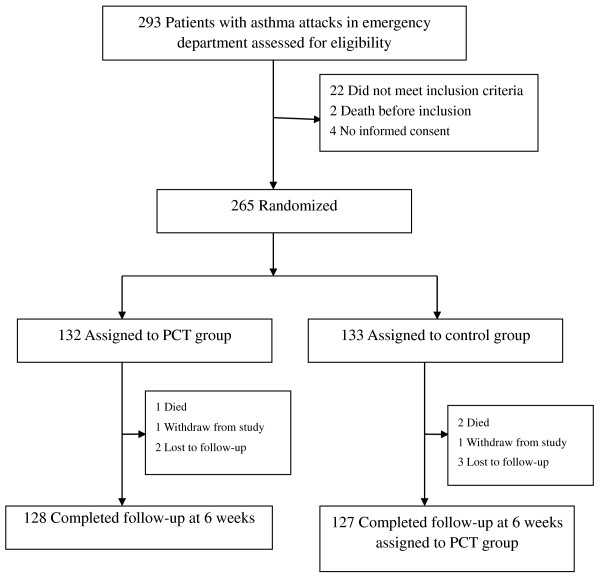
Patient flow chart.